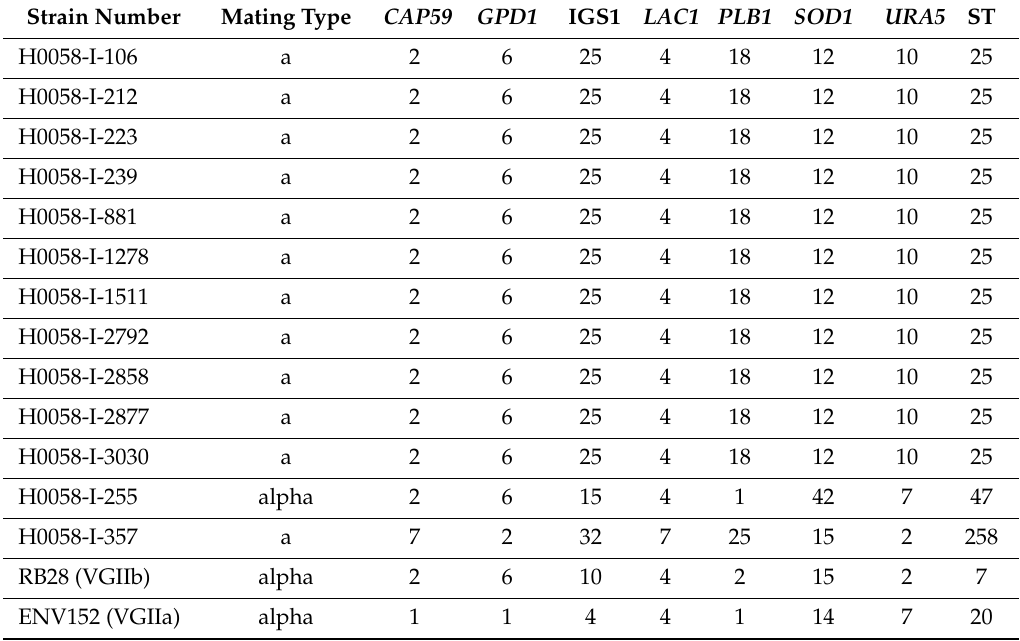
Table 2. Mating types, allele types (ATs), and sequence types (STs) of the studied Cryptococcus gattii VGII isolates. ATs and STs were identified through the MLST database at